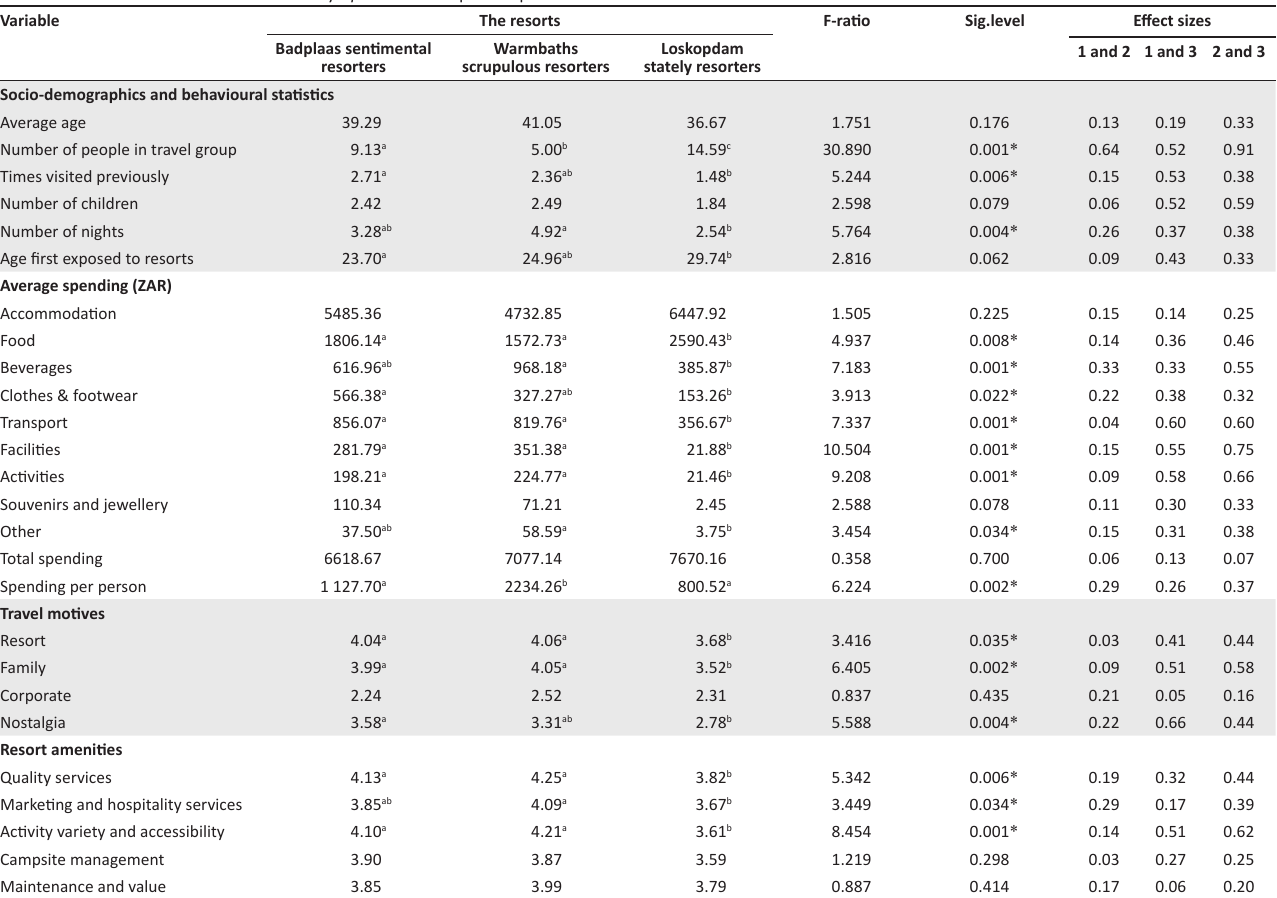
TABLE 6: Results from the ANOVA and Tukey’s post hoc multiple comparisons in the three resort markets.